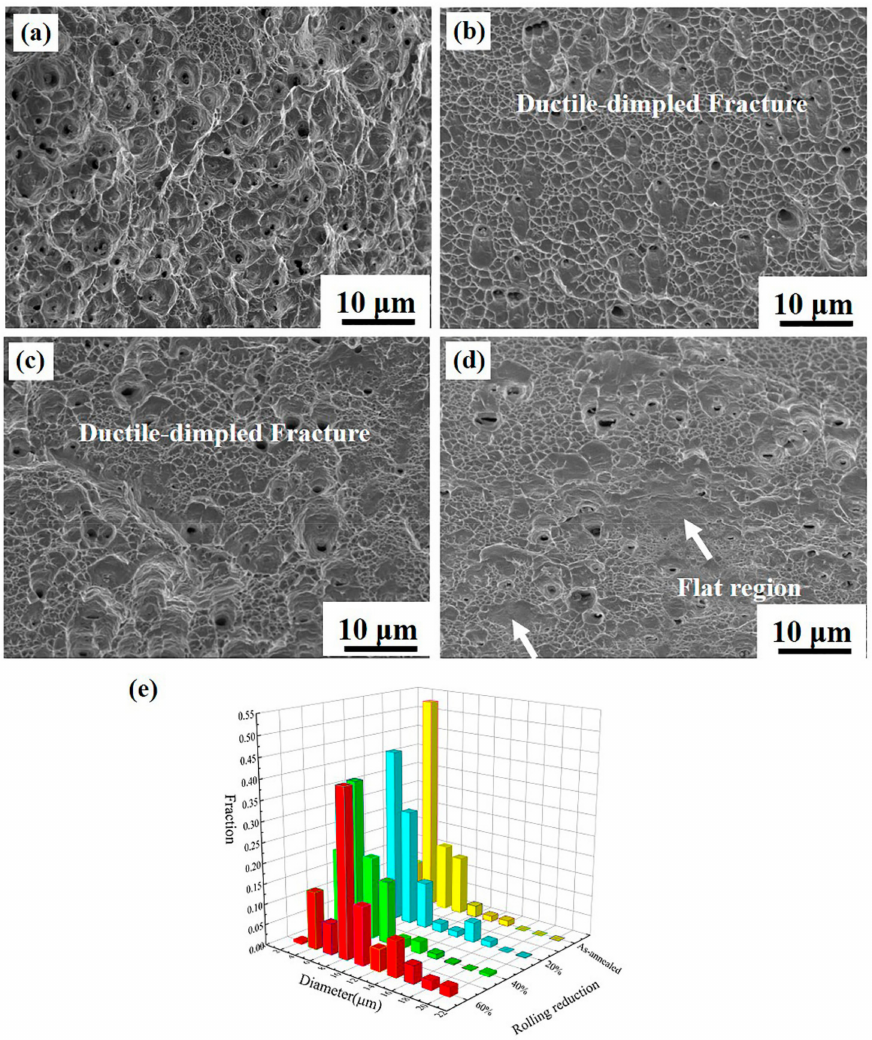
Figure 5. Fracture surfaces of tensile specimens with different rolling reductions: ( a ) 0%, ( b ) 20%, ( c ) 35%, ( d ) 55%, ( e ) rolling reduction dependence of the dimple